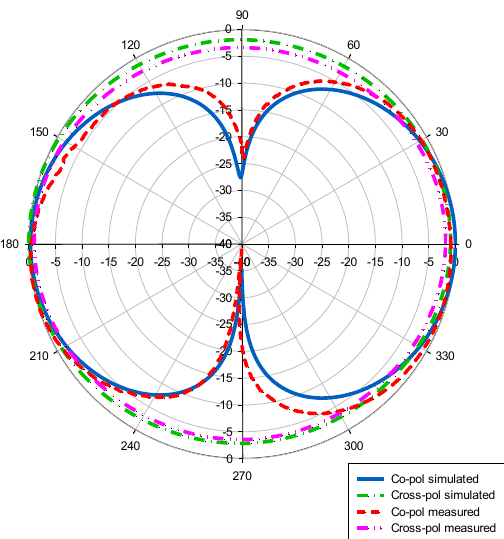
Figure 8: Simulated and measured normalized radiation patterns in the X-Z plane of the proposed slot antenna loaded with rotated square SRR.